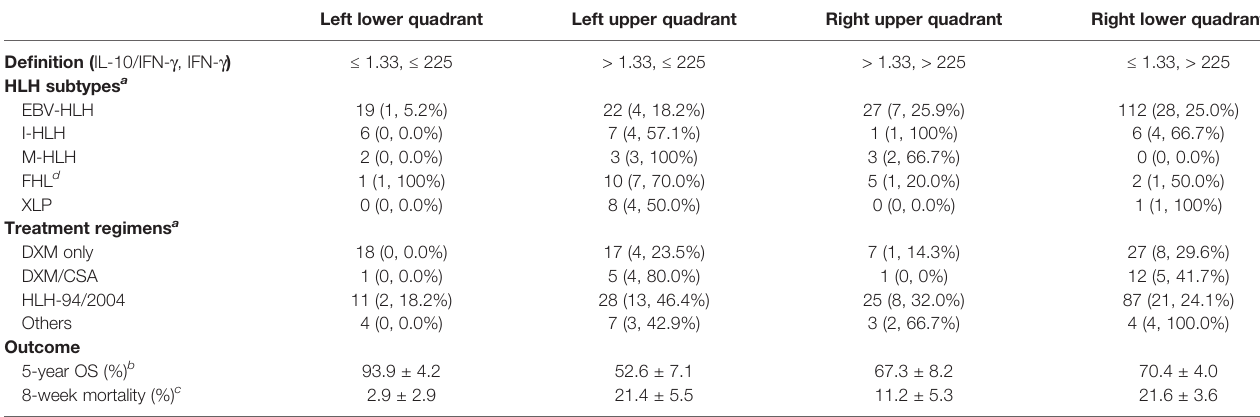
TABLE 3 | Clinical features of HLH patients located in different quadrants in a four-quadrant model. Left lower quadrant Left upper quadrant Right upper